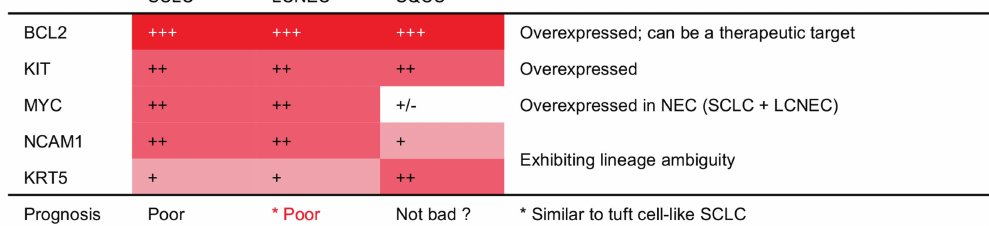
DLL3 , a Notch ligand with therapeutic relevance in SCLC [29], were signi fi cantly lower than in their non-tuft cell counterparts (Fig. 3B, C). Following the same line, tuft cell-like SQCC tended to show higher mRNA levels of NCAM1 than non-tuft cell-like SQCC (Fig. S8A). Moreover, immunohistological